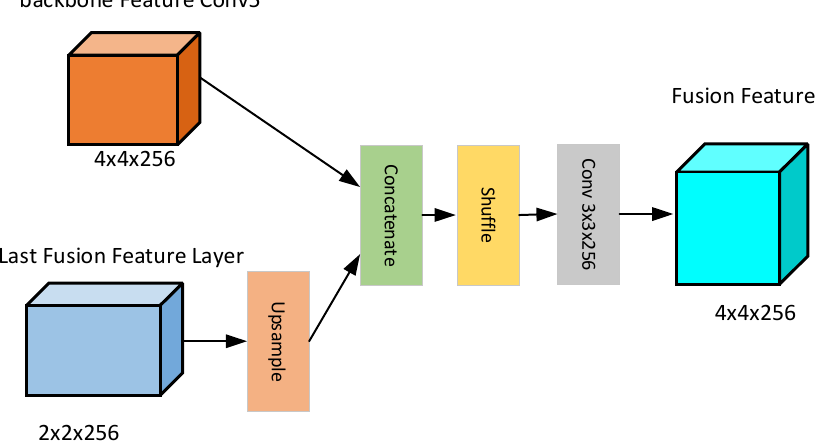
Figure 4. Feature fusion method. The deeper fused feature was up-sampled and concatenate with the upper feature. The fusion feature is generated by shuffling the concatenated feature and convoluted with a 3 × 3 convolution kernel.